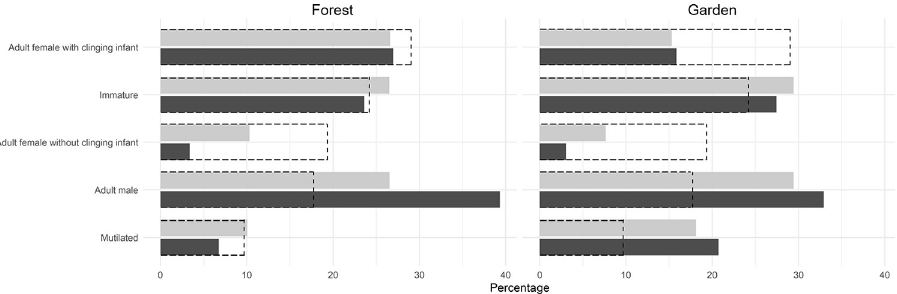
Fig 3. Ratio of occurrences during nocturnal activity of chimpanzees in function age-class, sex and mutilations according to the daytime and the habitat (the individuals not identified have been excluded). Bars represent the percentage of occurrences of age-sex classes during day (light gray) and night (dark gray) time. The dotted bars depict the percentage of an age-sex class in the Sebitoli chimpanzees’ community. Adults are non-mutilated individuals of over 15 years [84]; infants (under 3 years old) are dependent of their mother and counted together; immatures are healthy juveniles (from 3 to 9.9 years old) and sub-adults (from 10 to 14.9 years old) [84]; mutilated individuals of all age and class excluded from the other